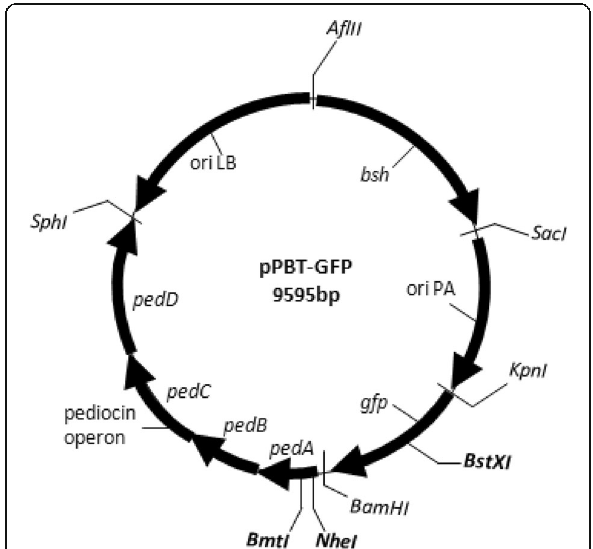
Fig. 3 Schematic model of shuttle vector pPBT-GFP showing potential insertion sites for cloning of heterologous inserts. Unique restriction enzyme sites for insertion by suppression of selectable markers are in bold case